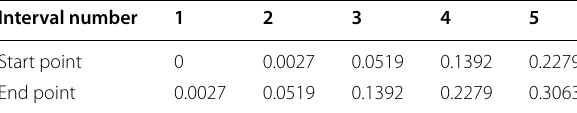
Table 8 Probability start and end points of each interval